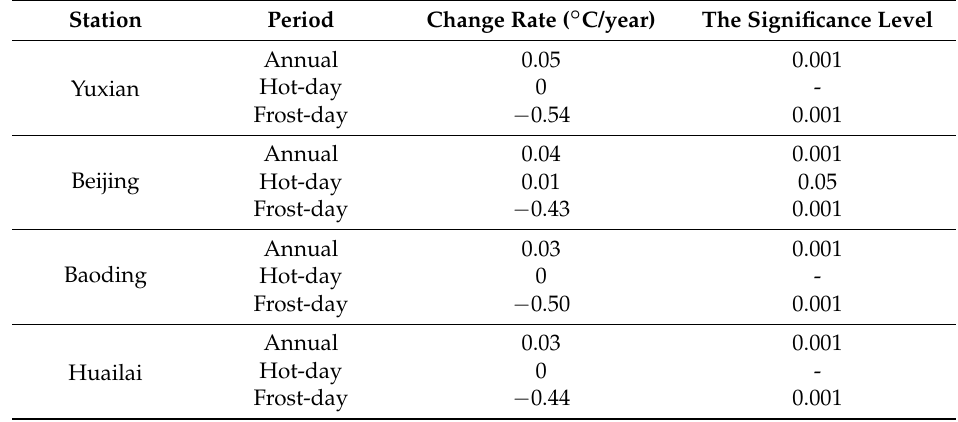
Table A1. The MK test for temperature time series.